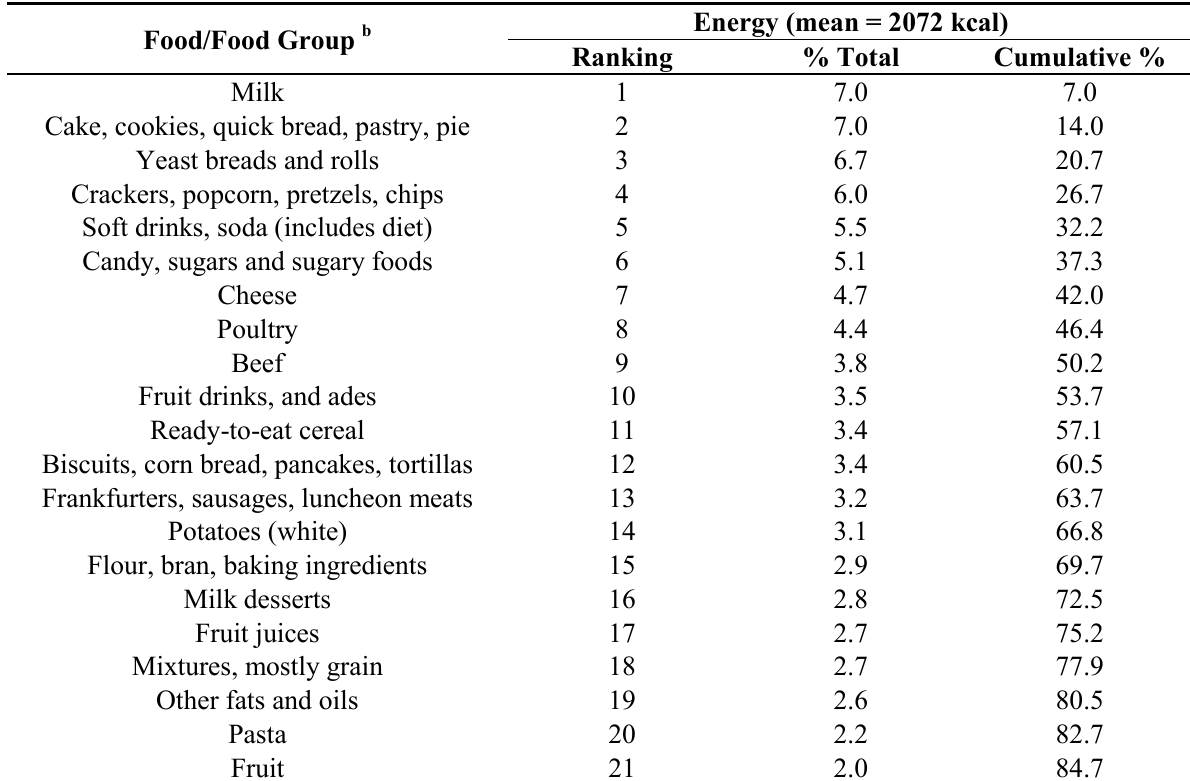
Table 1. Food/food group sources of energy among US children aged 2–18 years (from NHANES 2003–2006) a .